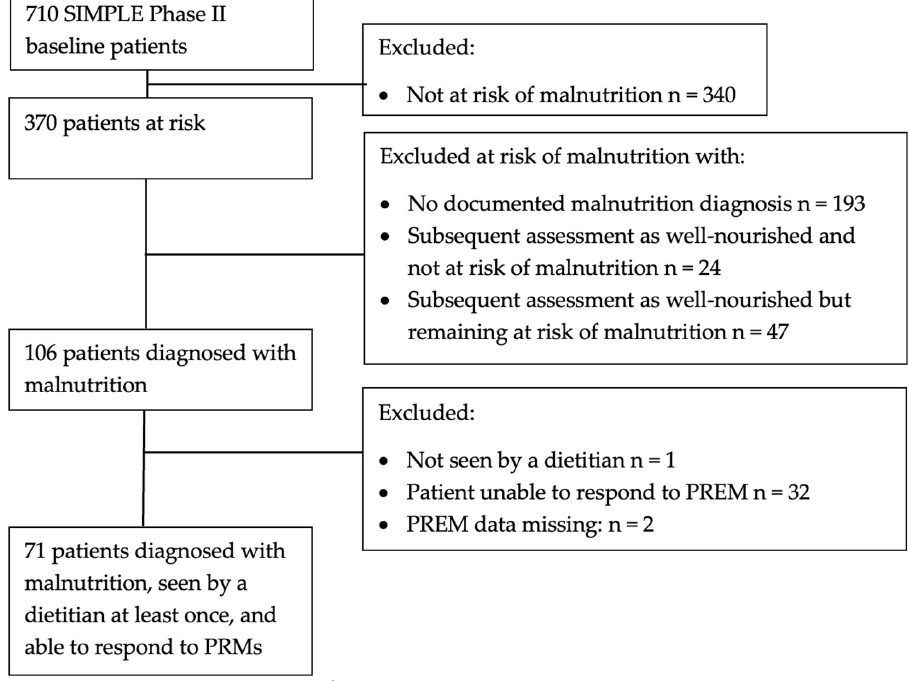
Figure 1. Participant fl ow diagram.